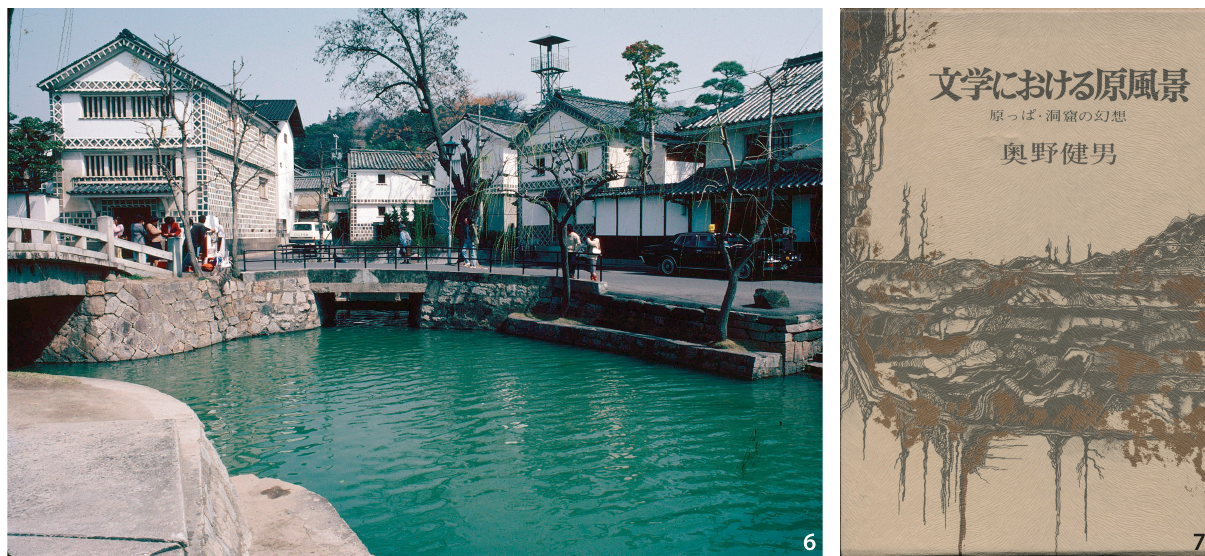
Figure 6 Kurashiki (Okayama prefecture), a pioneer in historical town conservation (Source: the author). Figure 7 Bungaku ni okeru Genfukei (Archetypal Images in Literature), Takeo Okuno, Shueisha, 1972.